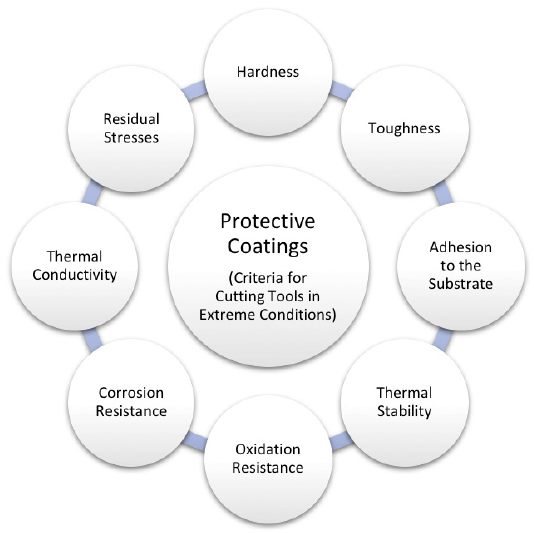
Figure 8. Criteria required for the success of the protective coatings of cutting tools.